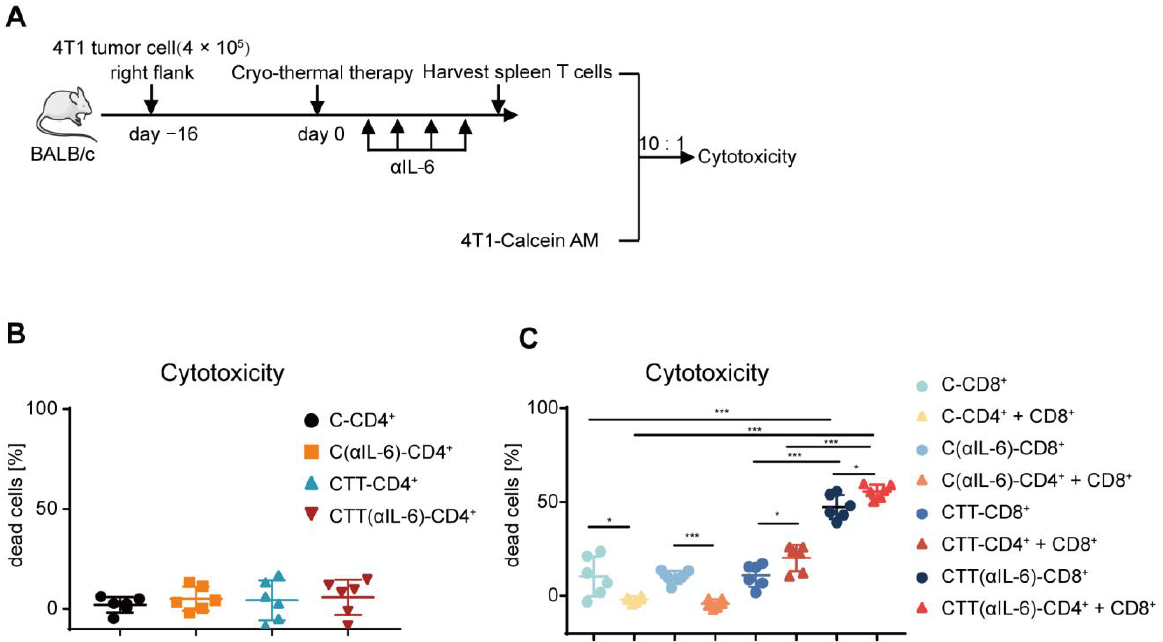
Figure 5. Tumor-killing ability of CD8 + T cells was mediated by CD4 + T cells. ( A ) 4T1 cells were labeled with 1 μM calcein-AM, and then co-cultured with splenic CD4 + and CD8 + T cells isolated by MACS at the E: T ratio of 10:1, six hours later, the cytotoxicy of T cells was analyzed by microplate reader. ( B , C ) The cytotoxicy of CD4 + T cells ( B ), and CD4 + T cells combined with CD8 + T cells ( C ). n = 6 for each group. * p < 0.05, *** p < 0.001. Data were analyzed using one-way ANOVA. C, tumor-bearing control; CTT, cryo-thermal